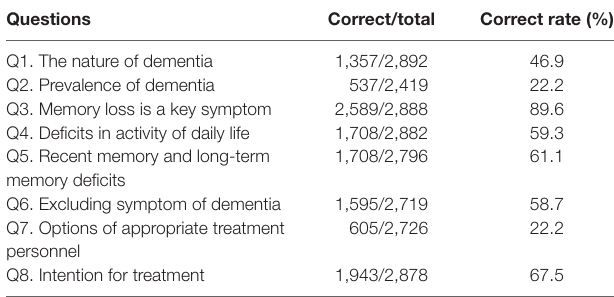
Table 2 | The correct rate of each question of the survey ( N = 3,007).